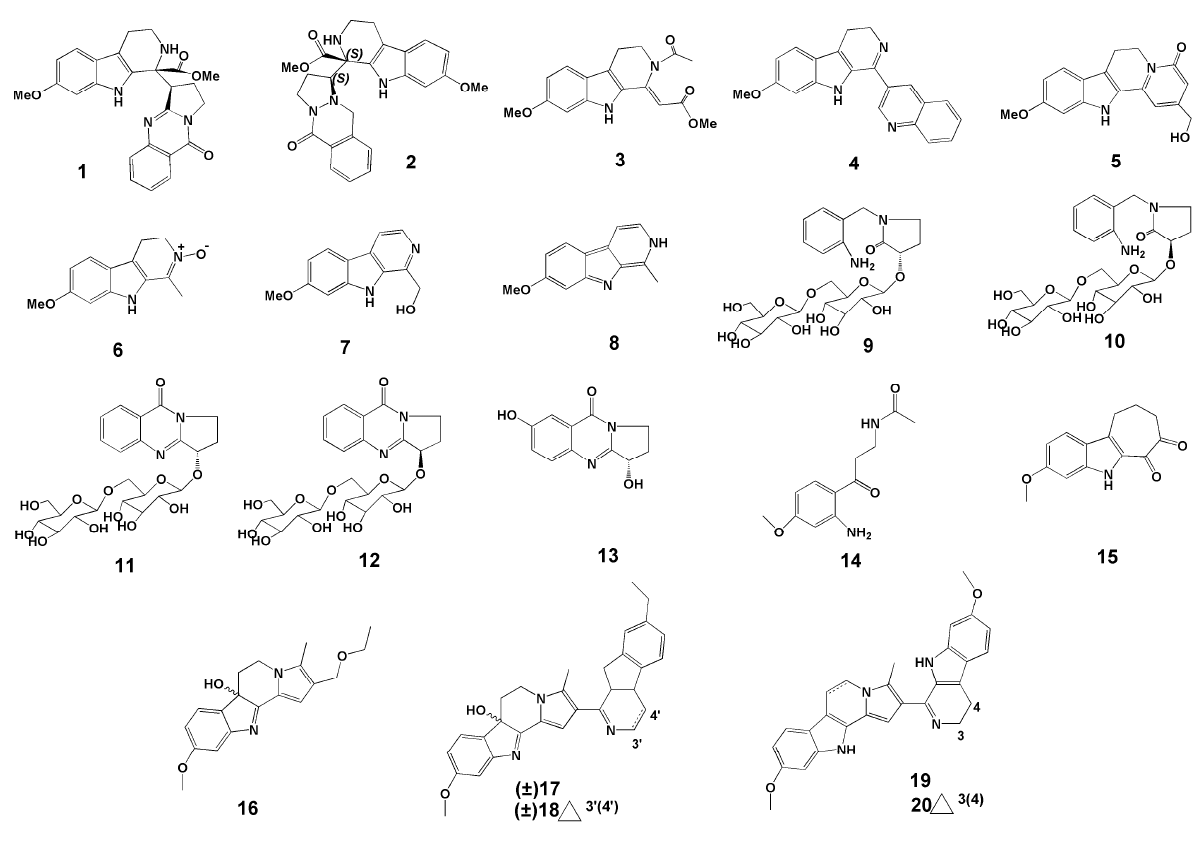
Figure 2. Structures of the twenty new compounds from P. harmala.